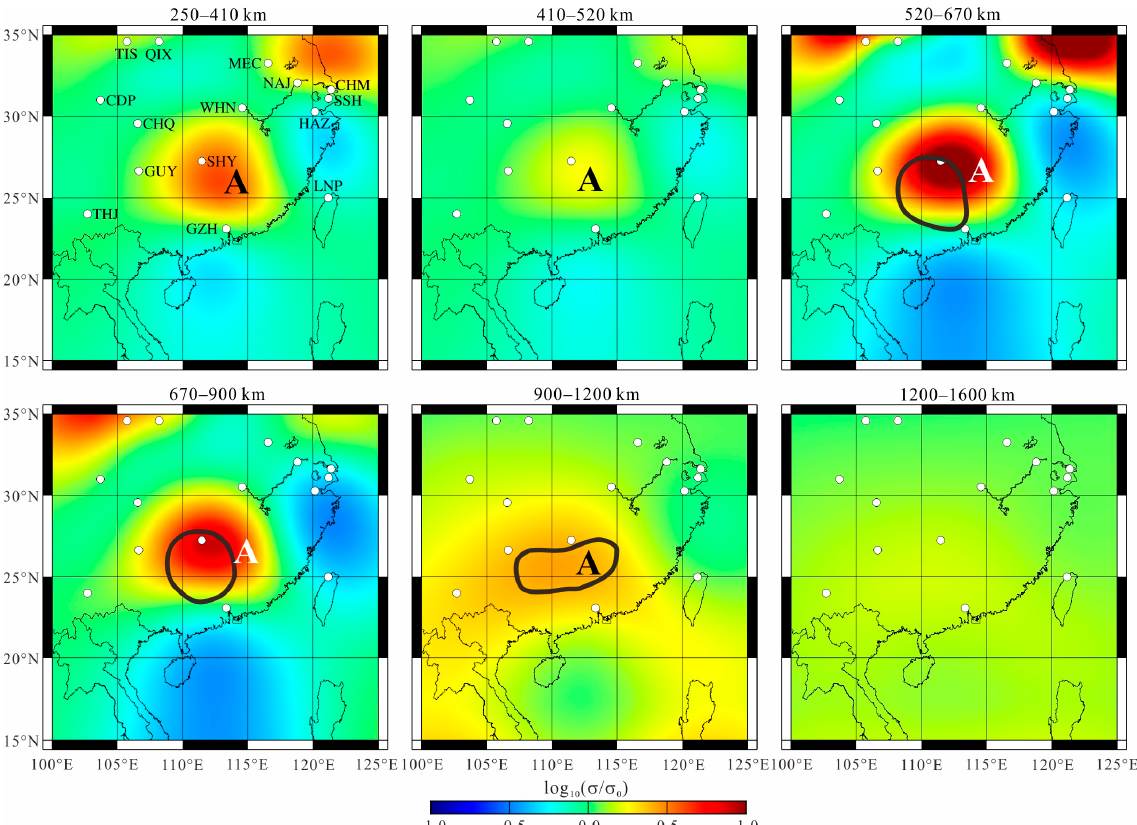
Figure 8. Electrical conductivity model of the mantle beneath South China. Label A represents the high conductivity zone named anomaly A. The black lines are the low-velocity zones observed via the teleseismic imaging of Xia et al. [10].